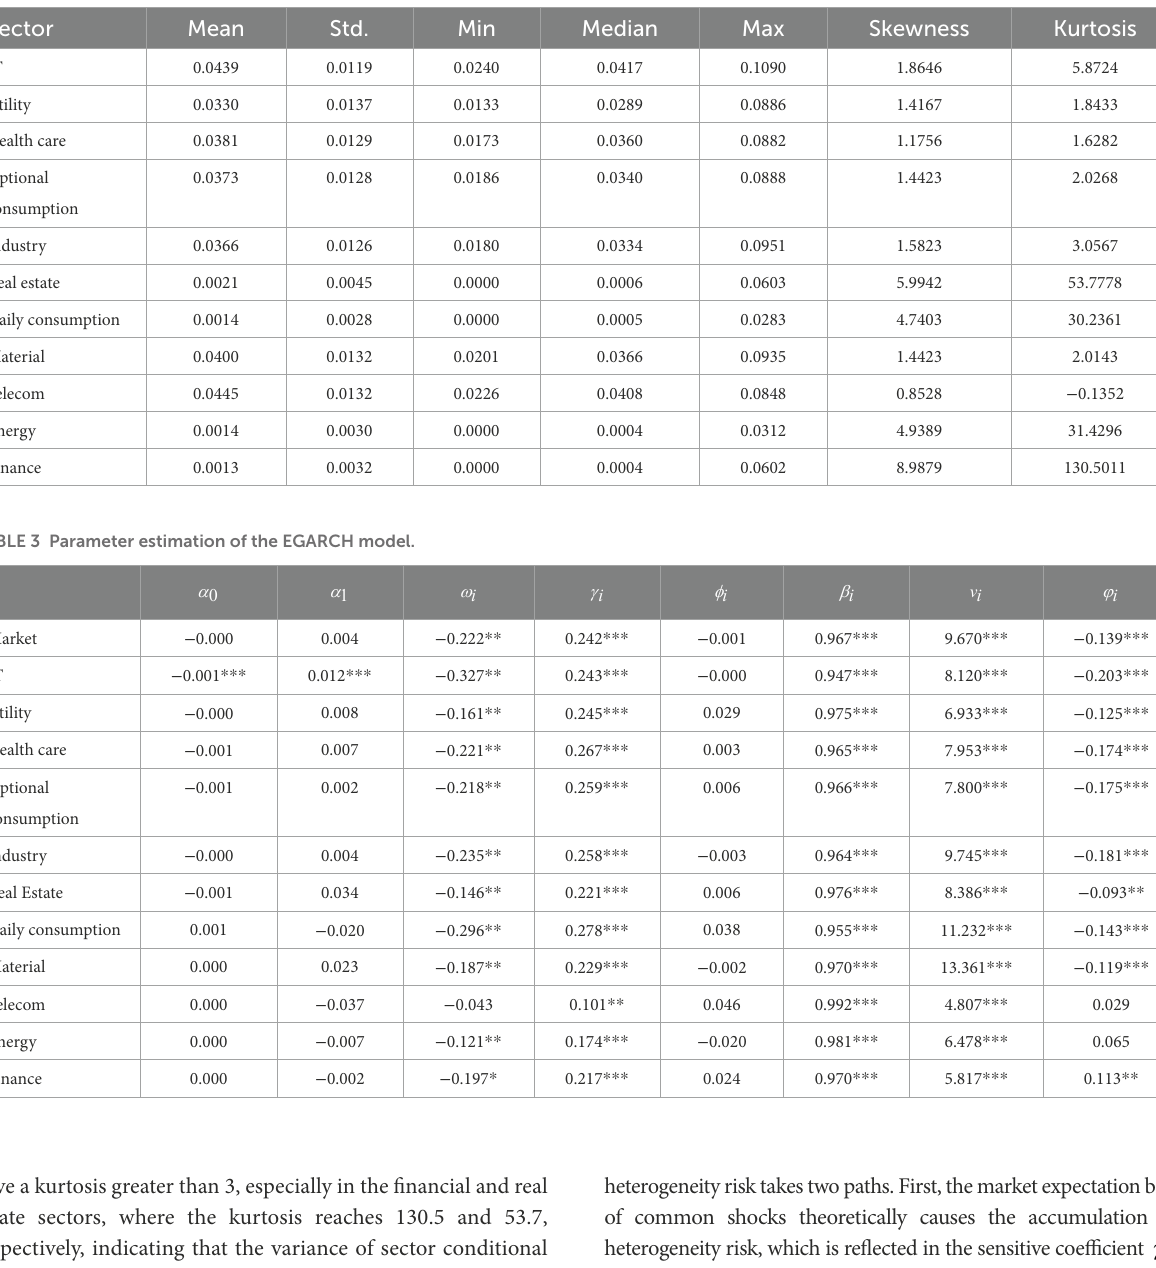
Figure 2 reflects the total systemic risk spillover index, SysRisk t , calculated by combining the left-tail and right-tail risk information under a 5% tail-event ( τ = 0.95) shock. As shown